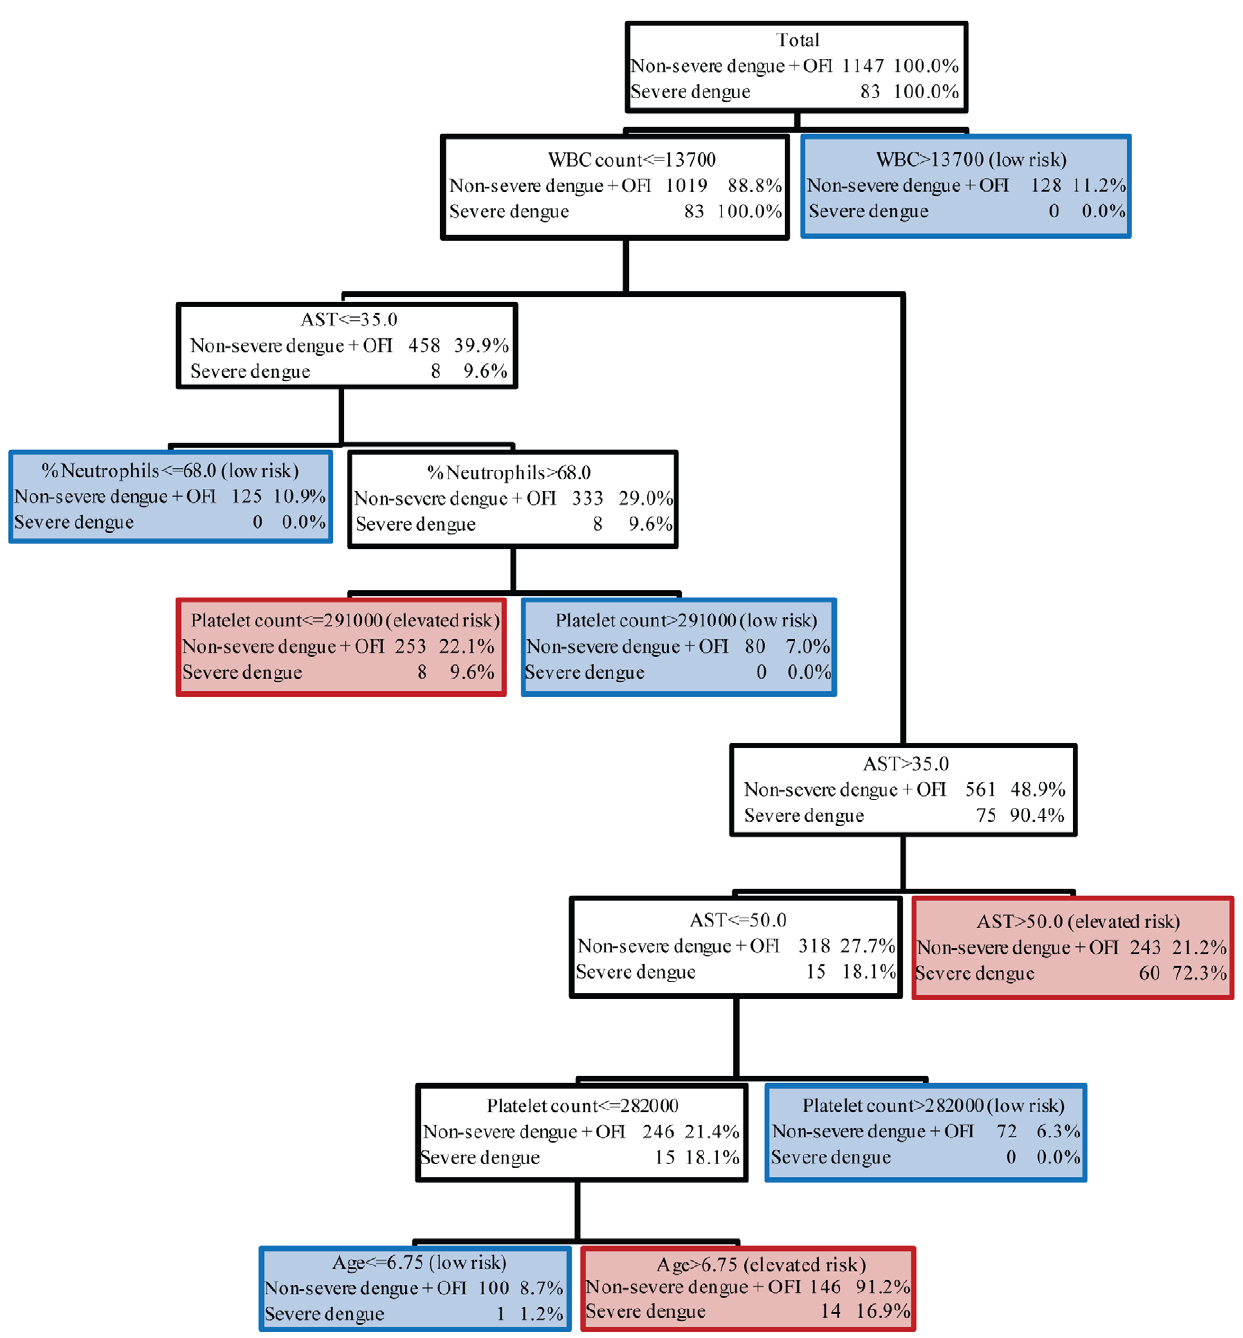
Figure 2. CART algorithm # 2 for identifying patients who subsequently developed severe dengue (defined as WHO criteria for dengue shock syndrome, DSS, or dengue with significant pleural effusion) using clinical laboratory data obtained within the first three days of illness. Pleural effusion index (PEI) . 15 was used as the criterion for significant pleural effusion. Each node is shown with the selected splitting variable, the number of patients with severe/non-severe or OFI, and the proportion of each from the parent node. Terminal nodes are marked as ‘elevated risk’ of severe dengue illness, outlined in red, and ‘low risk’ of severe dengue, outlined in blue.